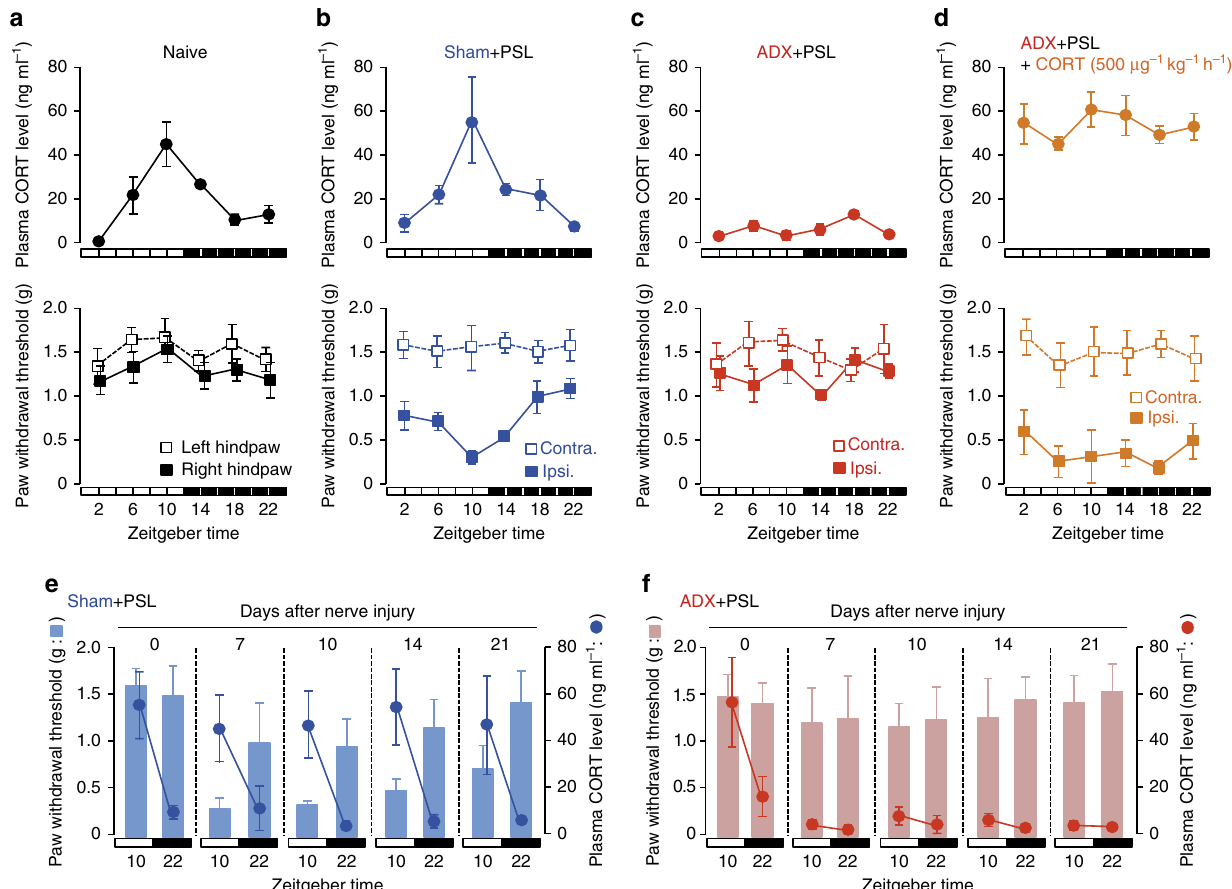
Figure 1 | Glucocorticoids regulate the diurnal oscillations in the threshold of mechanical allodynia in PSL mice. ( a – d ) Temporal profiles of plasma glucocorticoid levels and the paw withdrawal threshold in naive ( a ), sham þ PSL ( b ), ADX þ PSL ( c ) and CORT (500 m gkg (cid:2) 1 h (cid:2) 1 )-administered ADX þ PSL ( d ) male mice (means ± s.e.m.; n ¼ 5–6). The continuous administration of CORT (500 m gkg (cid:2) 1 h (cid:2) 1 ) to ADX þ PSL mice was performed by the subcutaneous (s.c.) implantation of an osmotic minipump. The withdrawal threshold of the nerve-injured ipsilateral (ipsi.) right hindpaw and sham- operated contralateral (contra.) left hindpaw of sham þ PSL, ADX þ PSL, and CORT (500 m gkg (cid:2) 1 h (cid:2) 1 )-administered ADX þ PSL mice was assessed by the von Frey up-down method. The withdrawal threshold of the right and left hindpaws of naive mice was also assessed by the same method. Significant time- dependent variations are observed in plasma CORT levels in naive ( F 5,30 ¼ 13.128, P o 0.001; ANOVA) and sham þ PSL ( F 5,30 ¼ 6.592, P o 0.001; ANOVA) mice, and in the withdrawal threshold of the ipsilateral hindpaw of sham þ PSL ( F 5,30 ¼ 5.482, P ¼ 0.011; ANOVA) mice. ( e , f ), An inverse relationship between diurnal oscillations in plasma CORT levels and the paw withdrawal threshold in sham þ PSL ( e ) and ADX þ PSL ( f ) male mice after nerve injury (means ± s.e.m.; n ¼ 6). Significant time-dependent variations are observed in plasma CORT levels ( F 7,40 ¼ 3.359, P ¼ 0.008; ANOVA) and in the withdrawal threshold of the ipsilateral hindpaw in sham þ PSL ( F 7,40 ¼ 2.655, P ¼ 0.024; ANOVA) mice. Neither plasma CORT levels ( F 7,40 ¼ 0.926, P ¼ 0.497; ANOVA) nor the withdrawal threshold of the ipsilateral hindpaw ( F 7,40 ¼ 0.647, P ¼ 0.715; ANOVA) show significant time-dependent variations in ADX þ PSL mice.